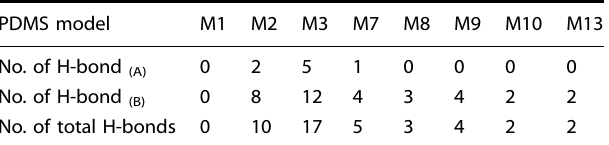
Table 1. The types and numbers of H-bonds in different PDMS models. PDMS model